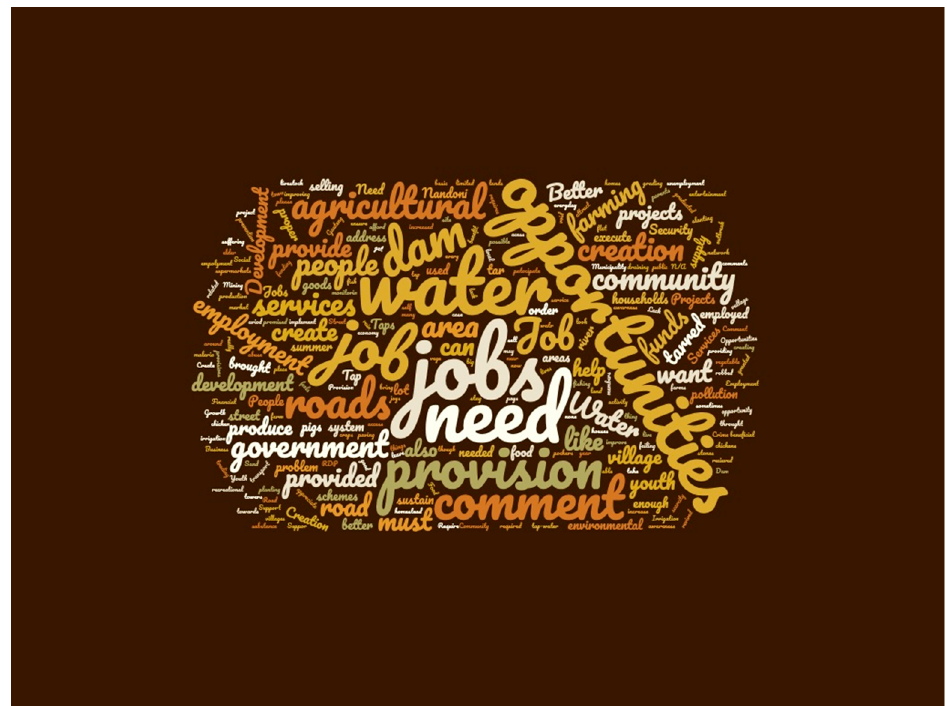
Figure 10. Common challenges faced by communities in the Nzhelele and Levuvhu river catchments.